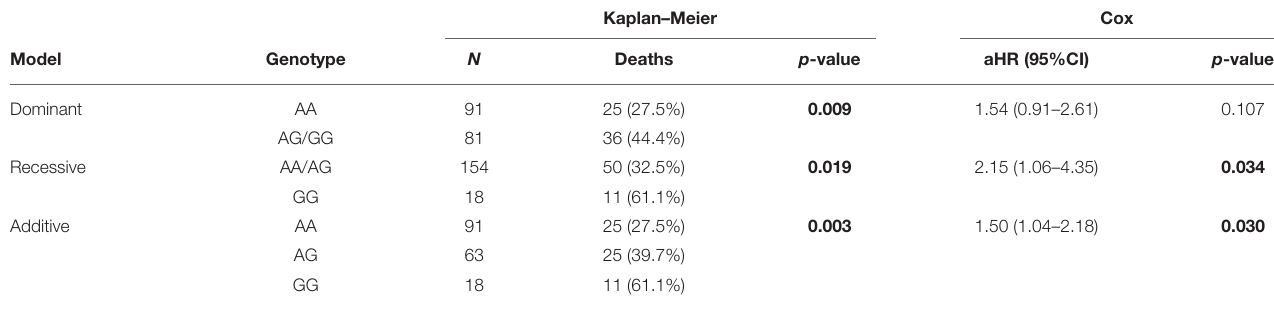
Statistics:valuesareexpressedasabsolutecountandpercentage,andhazardratioand95%confidenceinterval.Significantdifferencesareshowninbold.Abbreviations:aHR,adjusted hazard ratio; 95%CI, 95% confidence interval; p-value, level of significance; SNP, single nucleotide polymorphism; Cox, regression analysis adjusted by the most significant clinical and epidemiological